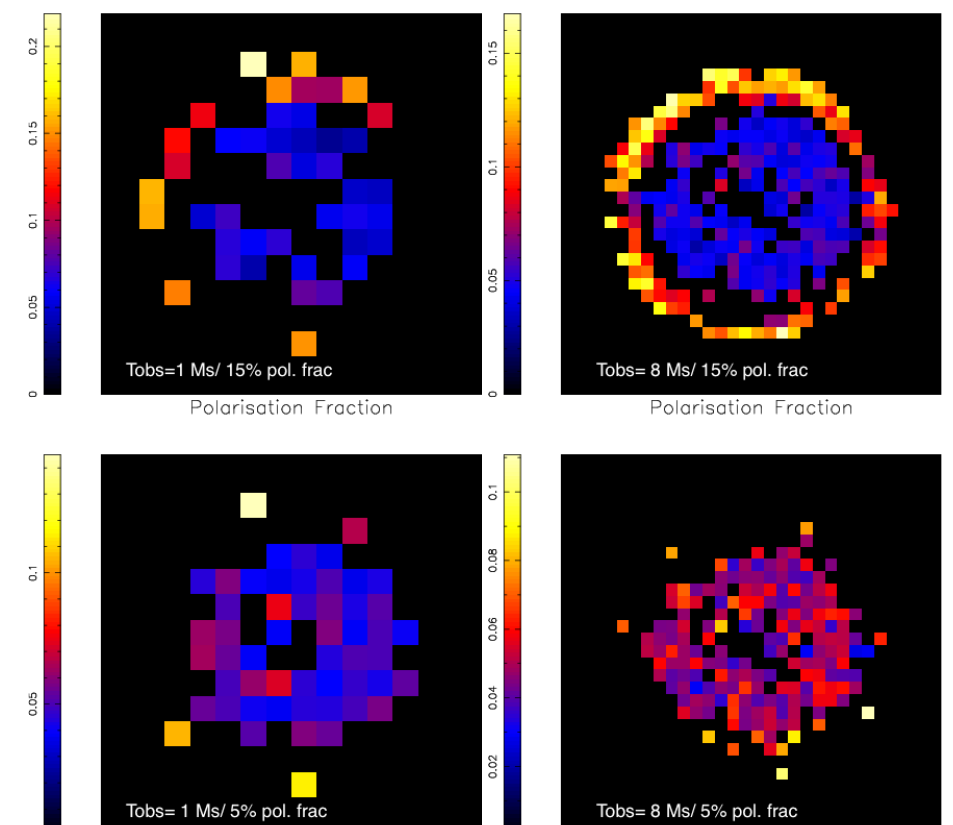
Figure 6. ( Top ) Polarisation fractions for simulations of Cas A with 1 Ms (( left ), pixel size 32 (cid:48)(cid:48) ) and 8 Ms ( right ) exposures. ( Bottom ) Simulated polarisation fractions, but now the outer filaments have input polarisation fractions of 5%. Both in the 2 Ms ( left ) and 8 Ms ( right ) the filaments are not detected as a coherent